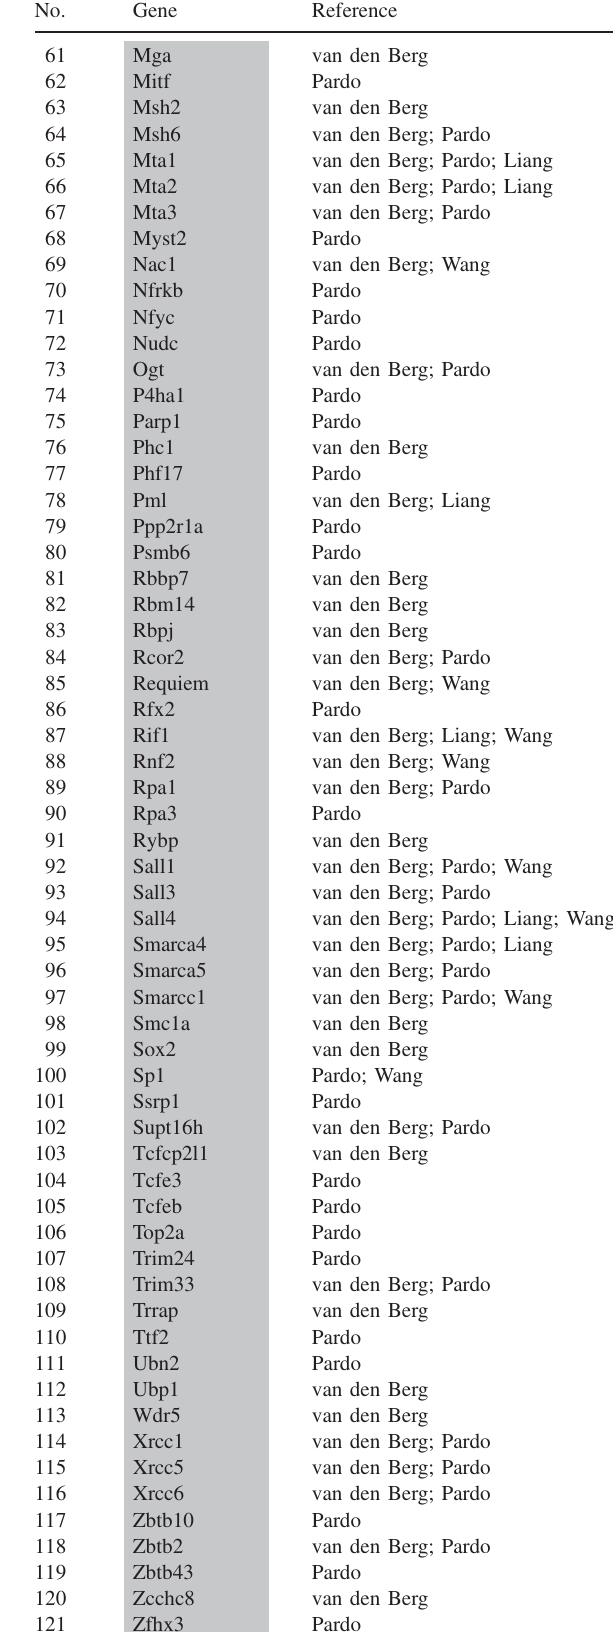
Table 2 Pluripotency-associated genes found via protein-protein